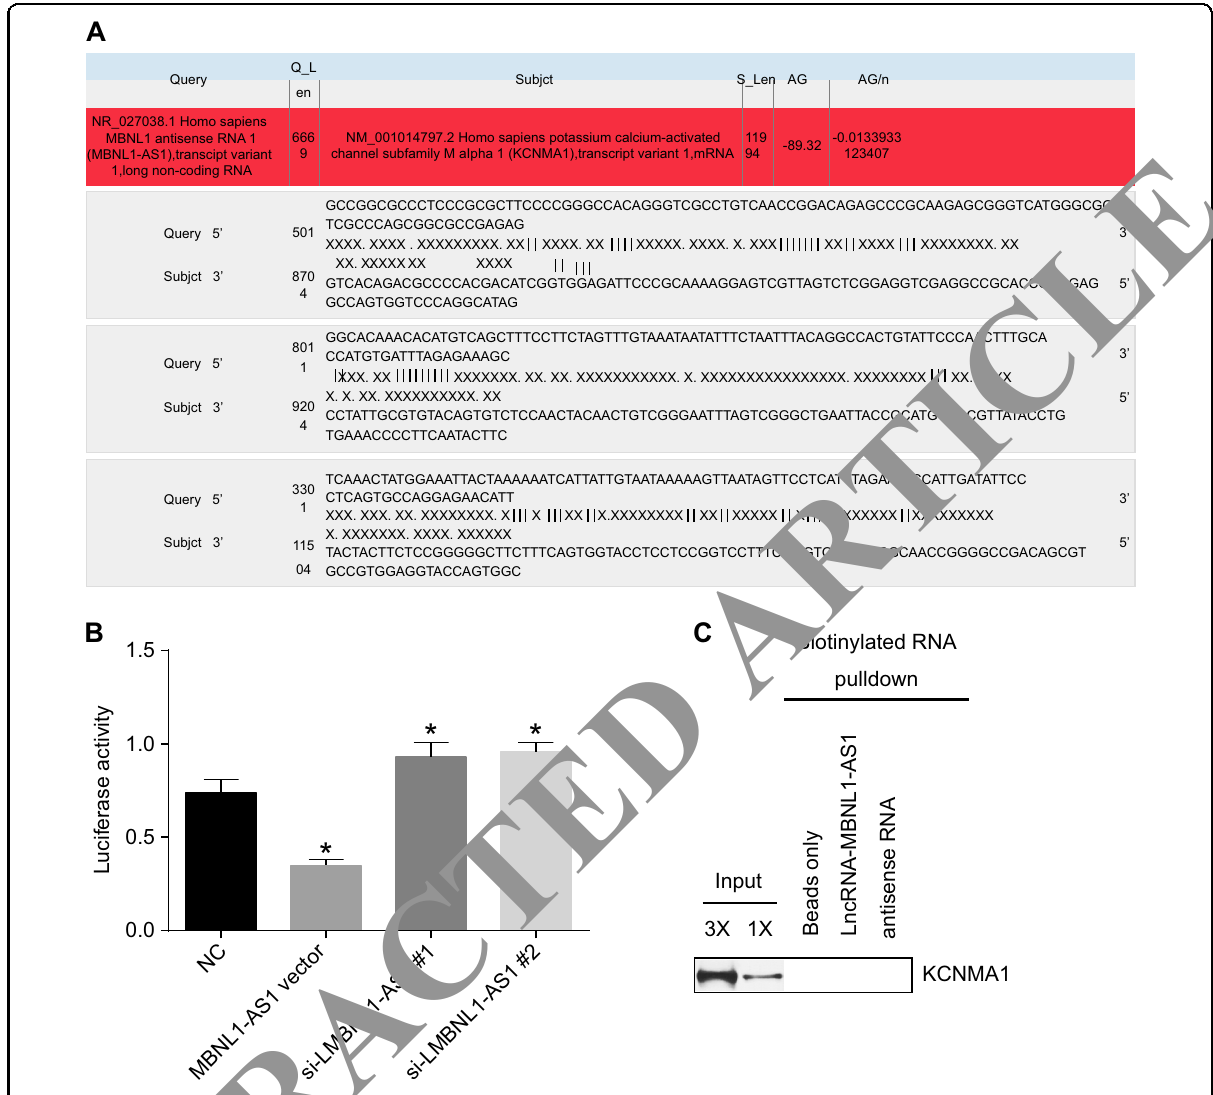
Fig. 5 MBNL1-AS1 targeted and negatively regulated KCNMA1. a The predicted consequential pairing between MBNL1-AS1 and KCNMA1. b Relative luciferase activity in the NC, MBNL1-AS1 vector, and siRNA-MBNL1-AS1 groups determined by the dual-luciferase reporter gene assay. c RIP results in each group. MBNL1-AS1 muscleblind-like 1 antisense RNA 1, KCNMA1 potassium calcium-activated channel subfamily M alpha 1, si small interfering, NC negative control; * p < 0.05 vs. the NC group; measurement data are expressed as the mean ± standard deviation. Comparisons among multiple groups were performed by one-way ANOVA; the experiment was repeated 3